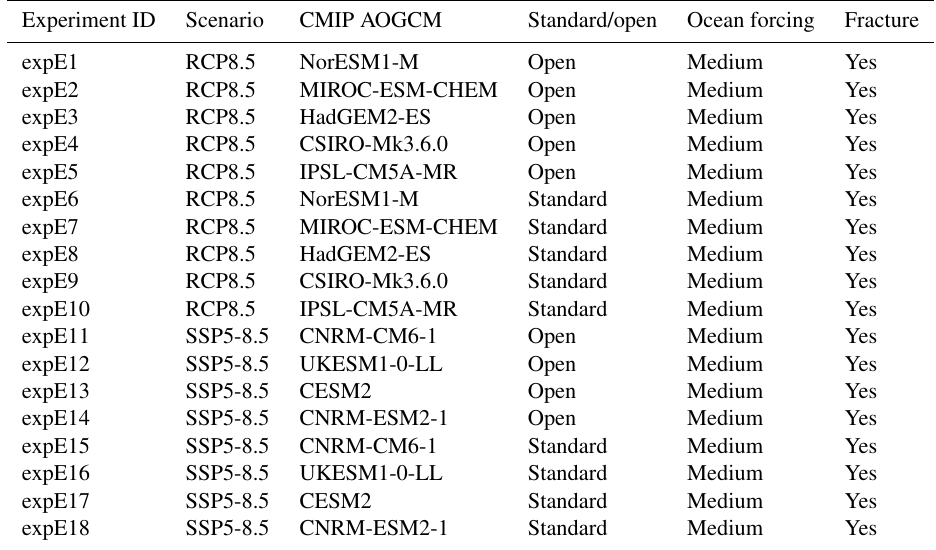
Table A4. Description of ISMIP6 Antarctica Tier 3 simulations to investigate impact of ice shelf